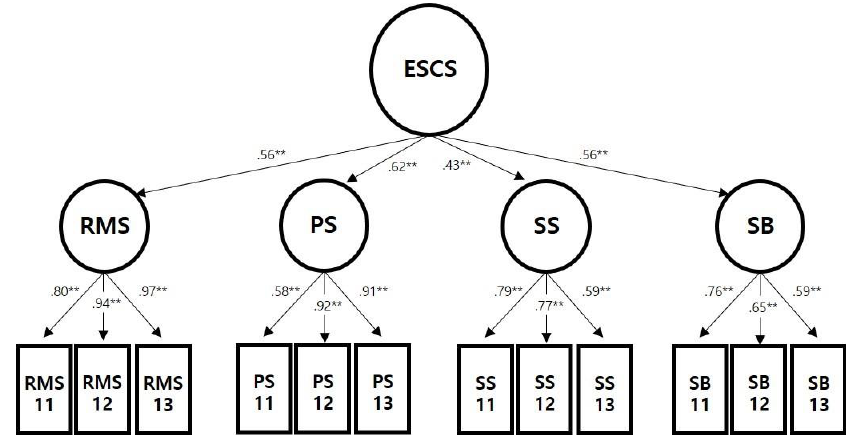
Figure 2. The final coping scale has four-factor and 12 items of second order model (M4). RMS = Religion/Mindfulness Support; PS = Professional Support; SS = Social Support; SB = Self-Blame. All parameters were significant at p level < .01 According to the correlation results between emotional coping and